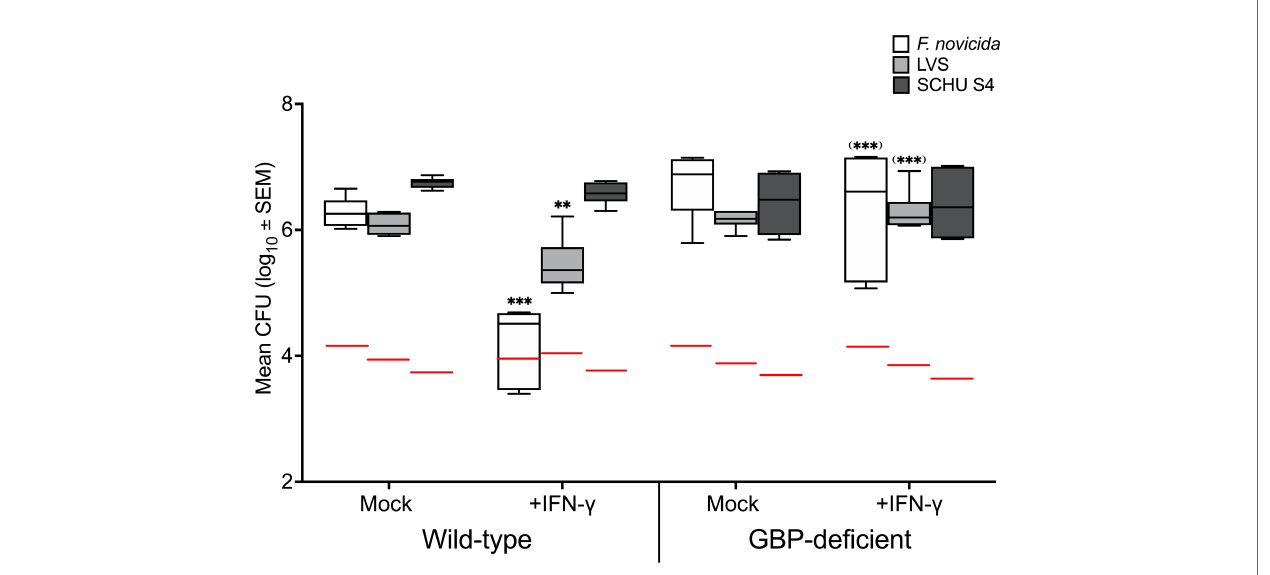
FIGURE 1 | Intracellular proliferation of F. tularensis strains in wild-type BMDM and GBP -/- BMDM. BMDM monolayer was infected using an MOI of 100 with SCHU S4, LVS or F. novicida in IFN- g primed and non-primed cultures. CFU numbers were recorded from triplicate wells and data are representative of three independent experiments, In each box plot, the line through each box shows the median, with quartile one and three as the lower and upper limits of each box. The end of the vertical lines indicates maximum and minimum values, respectively. The signi fi cances indicated without parenthesis are in comparison to mock wild-type BMDM and those within parenthesis indicate the values in comparison to the same infection of wild-type BMDM. ** P < 0.01, *** P < 0.001. The red lines indicate the